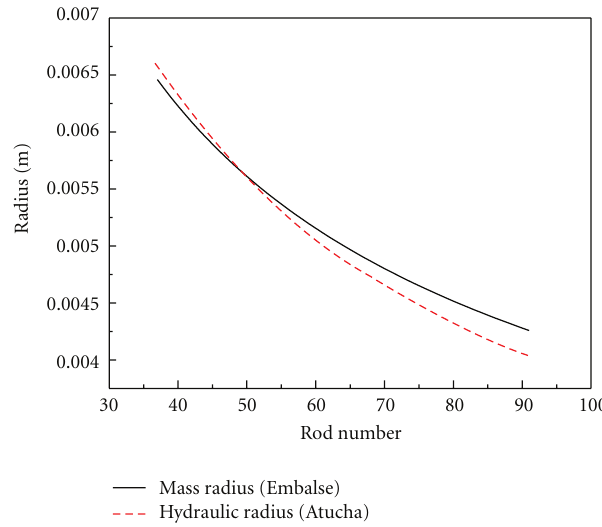
Figure 3: Fuel rod radii for keeping (1) hydraulic similarity and (2) fuel mass similarity.